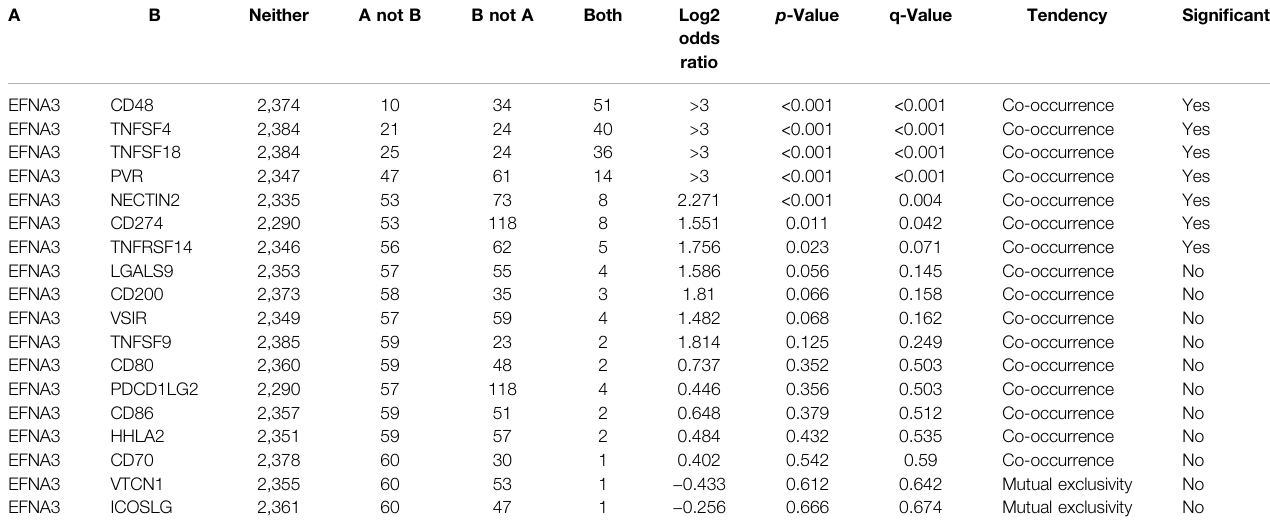
TABLE 4 | Mutual-exclusivity analysis between EFNA3 and multiple-immune checkpoints in gastric